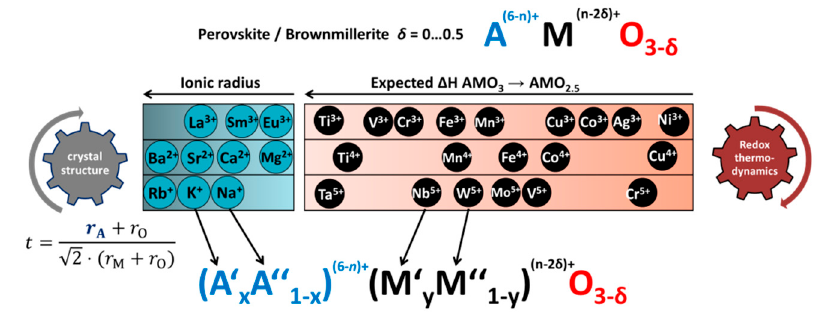
Figure 4. Creation of perovskite solid solutions with two M varieties and two A varieties, adapted from [25].